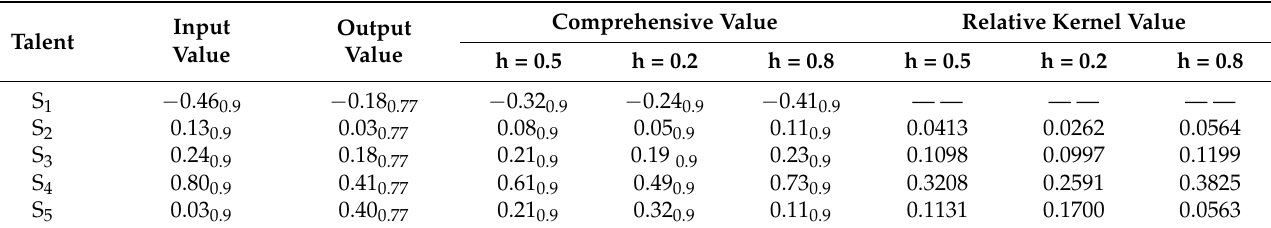
Table 7. Comprehensive value and relative kernel